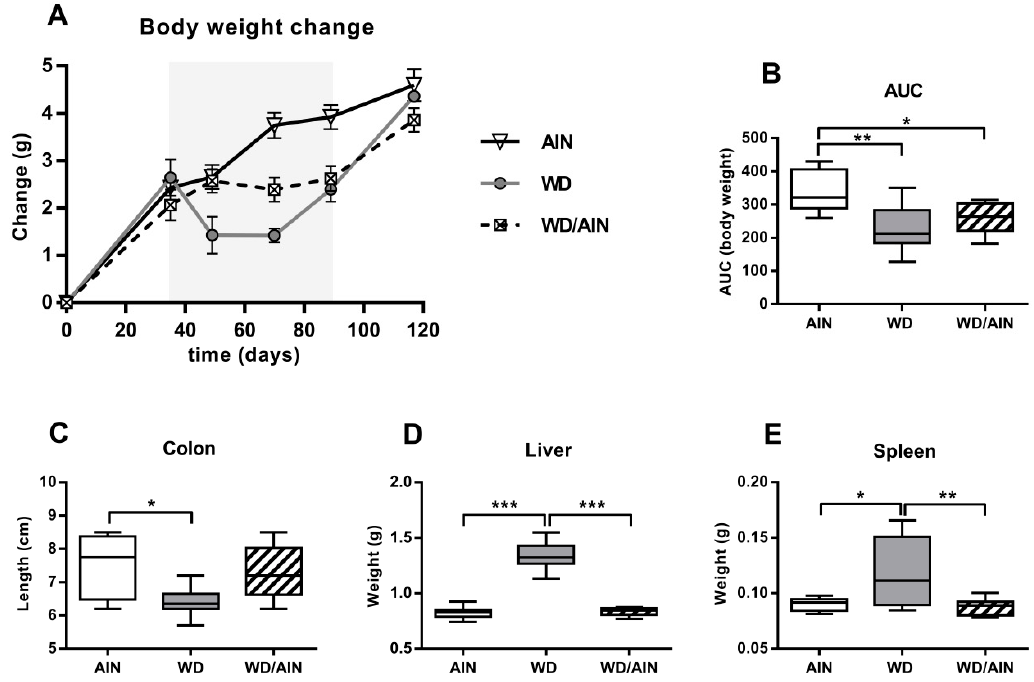
Figure 2. E ff ect of the WD on macroscopic changes ( A ) Body weight loss during the period of AOM / DSS administration (grey-shaded area). Day 0: Start of AIN93G or WD feeding, day 35: AOM i.p., day 49: End of first DSS cycle, day 70: End of second DSS cycle, day 89: End of third DSS cycle, and day 117: Day of sacrifice. Body weight of each mouse was set relative to day 0. Mean ± SEM, ( B ) Body weight changes based on the analysis of the area under the curve (AUC) during the whole experimental period of 117 days. ( C ) E ff ect of the diet on colon length, ( D ) liver, and ( E ) spleen weight measured on the day of sacrifice. n = 8, median, interquartile range, and whiskers (min to max); ANOVA with Tukey post-hoc test; * p < 0.05, ** p < 0.01, and *** p < 0.001.